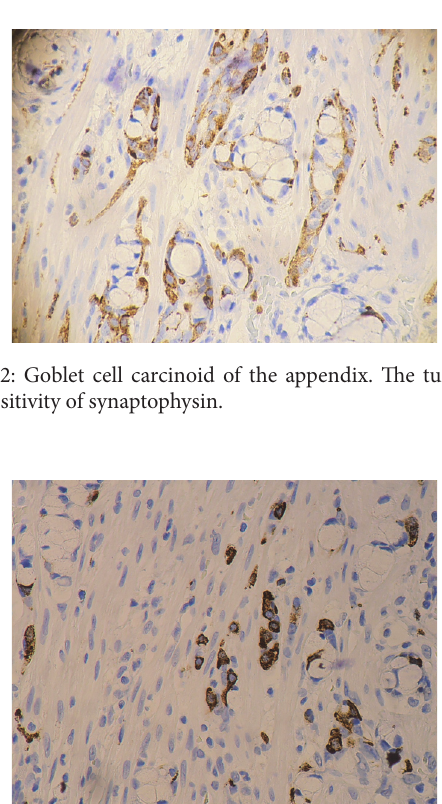
Figure3:Gobletcellcarcinoidoftheappendix.Immunohistochem- ically, the endocrine cell component is positive for